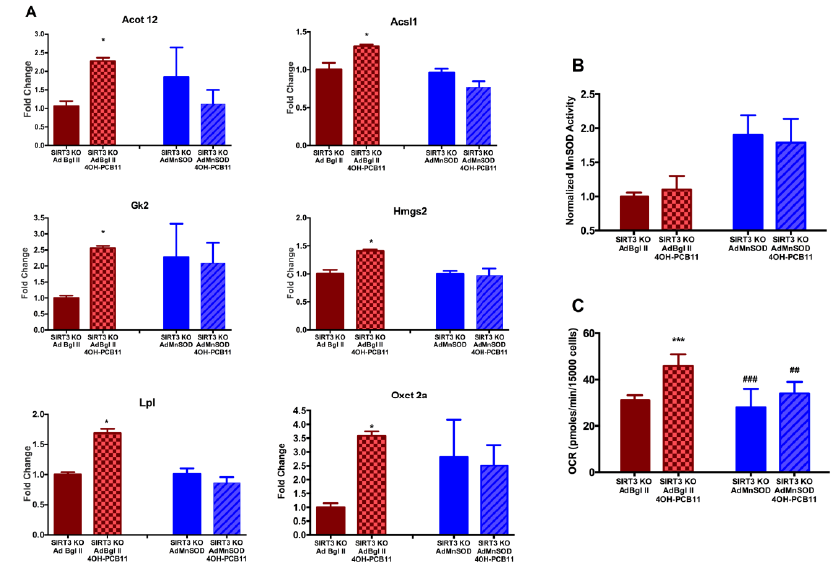
Figure 7. Overexpression of MnSOD could reverse the 4OH-PCB11 induced increases in expression of genes associated with FAO as well as decrease the elevated mitochondrial respiration following polychlorinated biphenyl (PCB) treatment. SIRT3-KO MEFs were incubated with replication-incompetent adenoviral vectors (100 MOI), AdCMV Bgl II (AdBgl II), or AdCMV MnSOD (AdMnSOD) for 24 h. Then, the medium was changed, and the cells were incubated for an additional day before treatment with 3 μM 4OH-PCB11 or vehicle for 24 h. qRT-PCR was repeated for the FAO pathway genes that were significantly upregulated in the previous experiment, see Figure 6 ( n = 3). * p < 0.05 compared to AdBgl II control ( A ). MnSOD activity was measured in cell homogenates. Data represents the average and error range of two independent treatment dishes per group ( B ) The oxygen consumption rate (OCR) was measured with Seahorse Extracellular Flux analyzer. Data are the mean ± 1SEM of independently infected and treated 14–16 wells. *** p < 0.001 as compared to vehicle-treated AdBgl II group. ## p < 0.01 and ### p < 0.001 as compared to vehicle-treated AdMnSOD group ( C